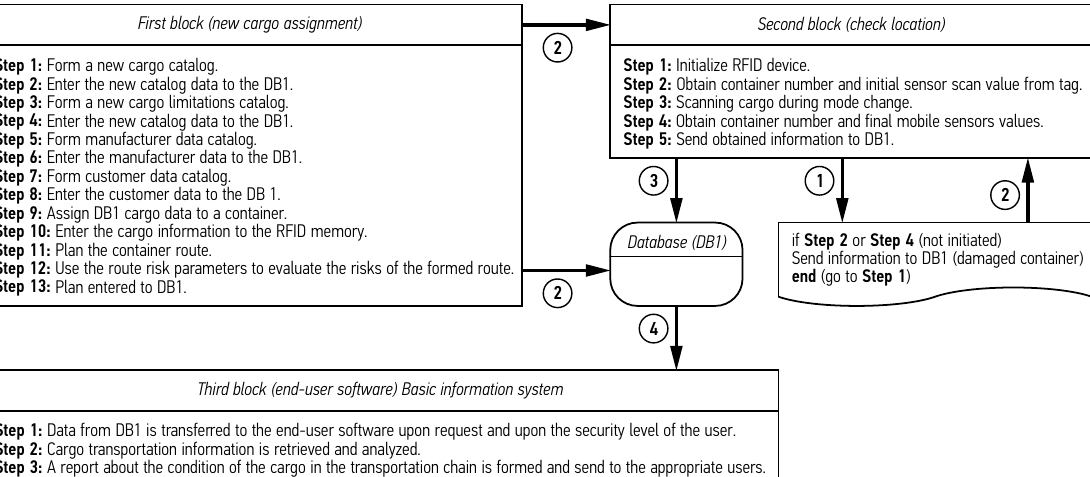
Fig. 2. A description of the information